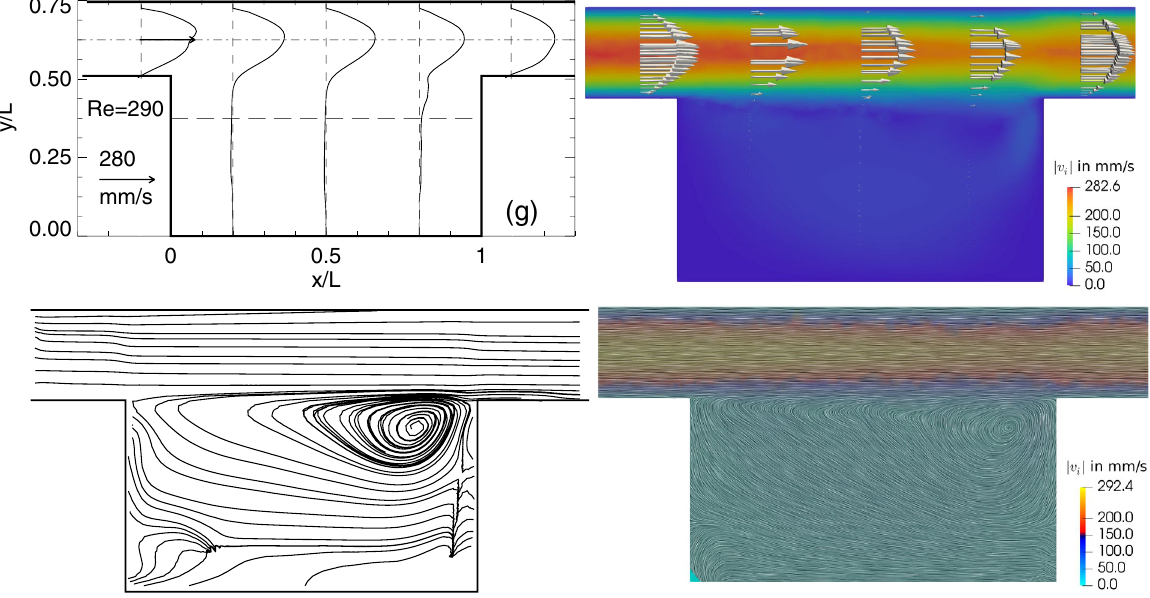
Fig. 12 Comparison of measurement and calculations: Case (g) PIV left column and CFD right column. Selected velocity profiles (top row) and streamlines (bottom row) are